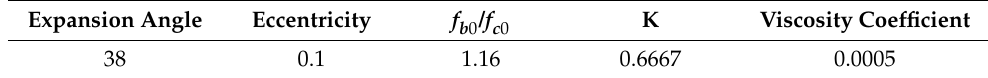
Table 6. Plastic damage model parameters.